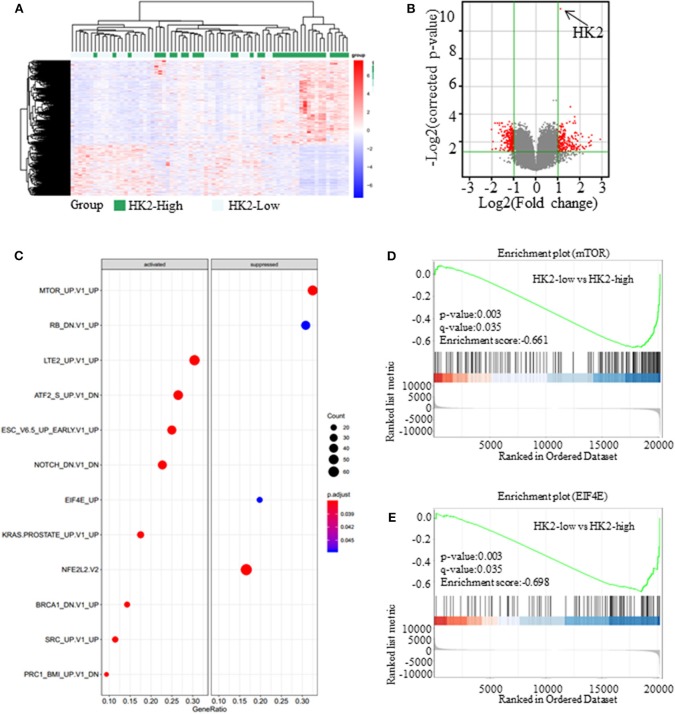
Inhibiting HK2 induces activation of the AMPK signaling pathway. (A) The expression of different genes in High-HK2 and Low-HK2 samples from the GSE43580 cohort. (B) Volcano map showing the differentially expressed genes (fold change > 2, p < 0.05, red dots are up-regulated genes and down-regulated genes). (C) GSEA shows the differential signaling pathways enriched from differential genes. (D) Running enrichment score of mTOR in GSEA. (E) Running enrichment score of mTOR in GSEA.